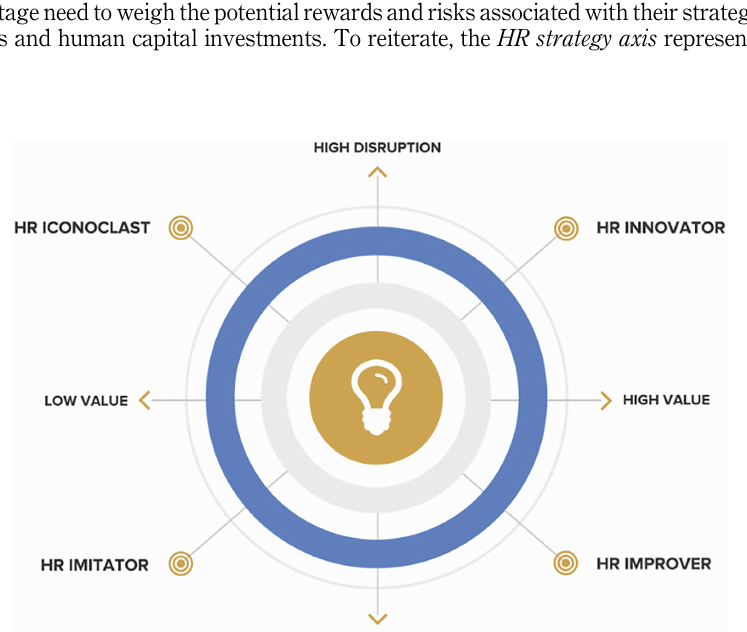
Figure 2. HR strategy